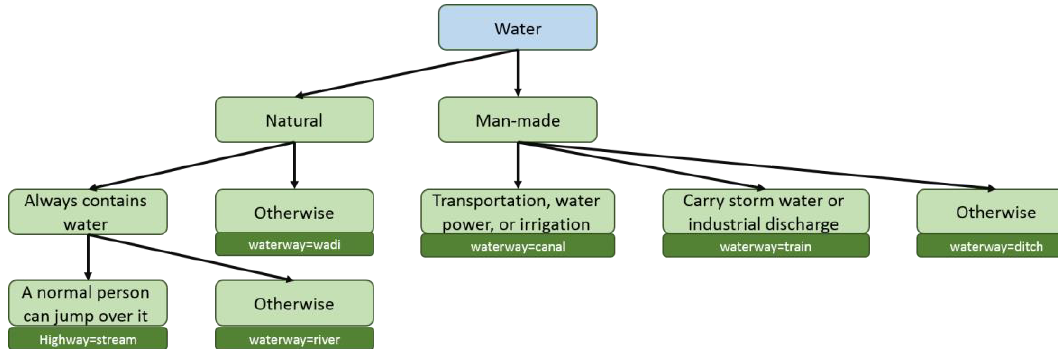
Figure 5. Expanded view of "Water" box in Figure 1.